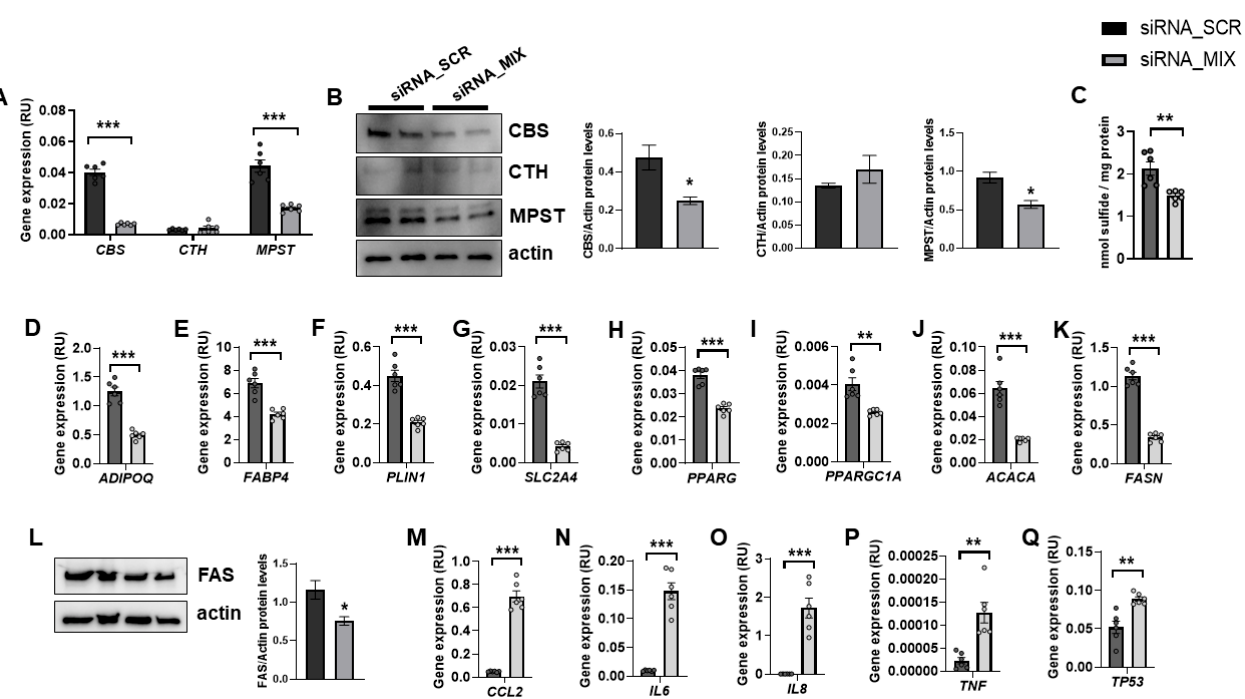
Figure 1. The impact of the combined partial knockdown of CBS and MPST gene on relevant genes for adipocyte biology. The effect of siRNA_MIX administration on CBS , CTH and MPST mRNA ( A ) and protein ( B ) levels, on intracellular sulfide levels ( C ), and on expression of adipogenic ( ADIPOQ, FABP4, PLIN1, SLC2A4, PPARG, PPARGC1A )-, lipogenic ( ACACA, FASN )-, proinflammatory ( CCL2, IL6, IL8, TNF )- and cellular senescence ( TP53 )-related genes and on FAS protein levels ( D – Q ). * p < 0.05, ** p < 0.01 and *** p < 0.001 compared to